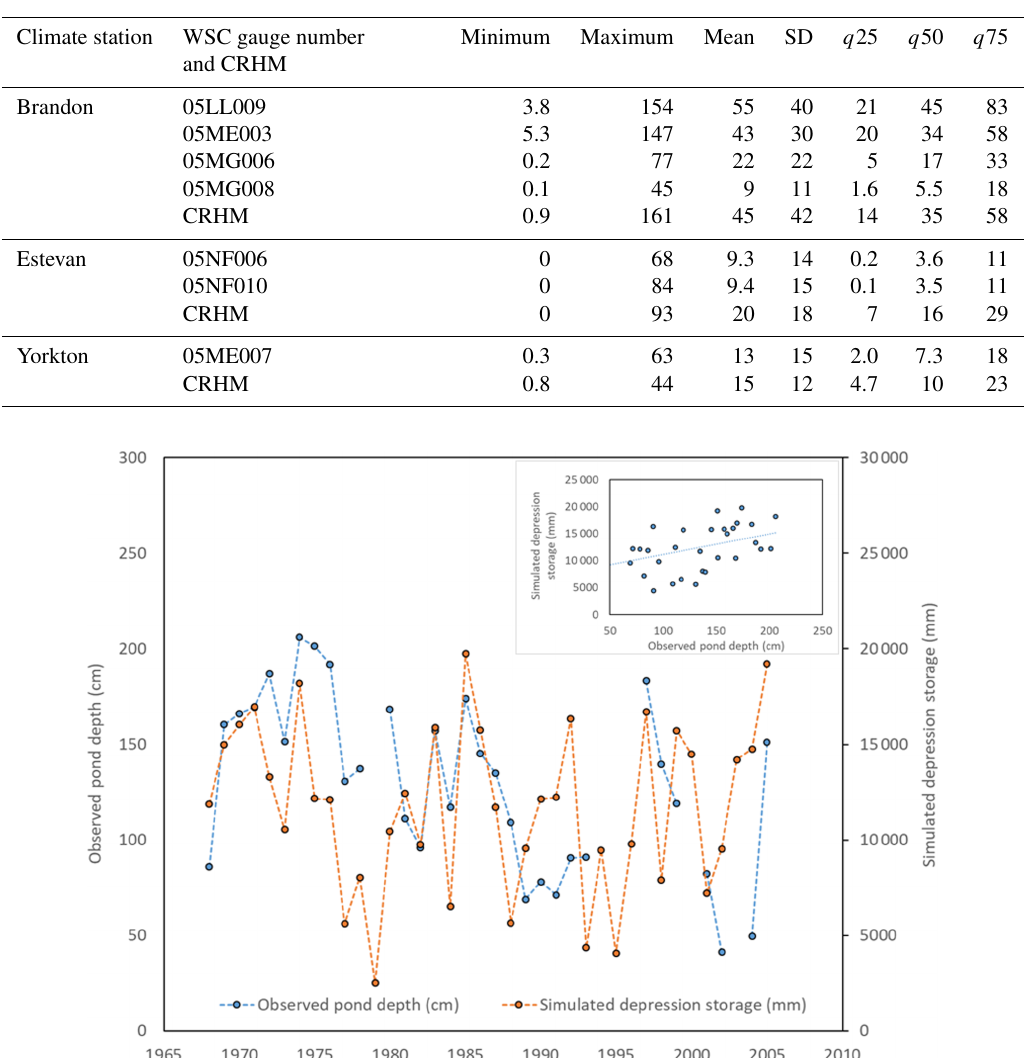
Table 4. Simulated (CRHM) baseline annual runoff (mm) for the PHT virtual basin for three of the four climate locations and observed annual runoff from corresponding WSC hydrometric gauges. The 25th, 50th, and 75th percentiles are denoted with q 25, q 50, and q 75 and the standard deviation with SD.